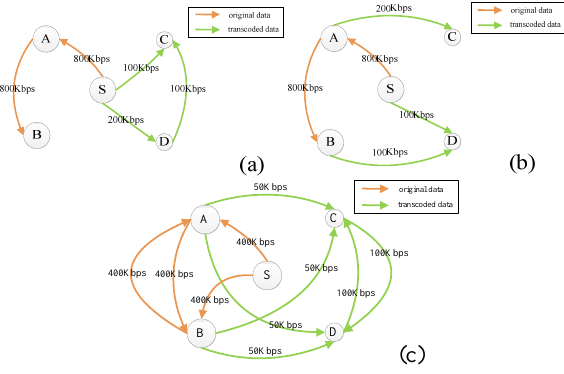
Figure 2. Examples of flow rate allocation in